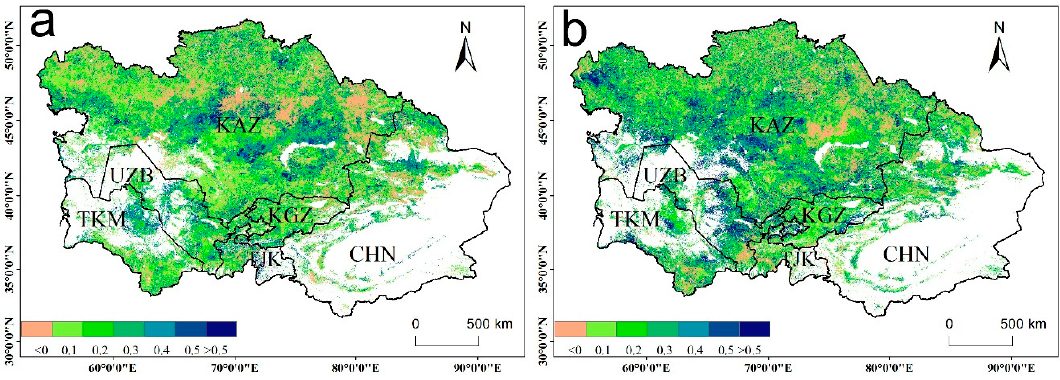
Figure 6. Different model R 2 values between ( a ) previous one year and the current year, and ( b ) previous two years and previous one year. White areas represent barren, snow, and water body pixels.